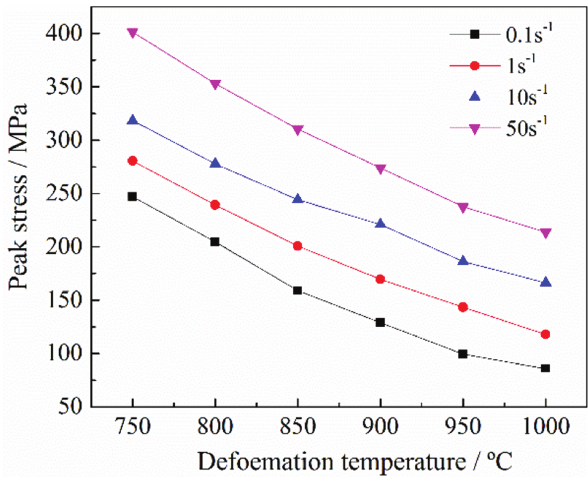
Figure 3: Peak stress in the isothermal compression of 49MnVS3 non-quenched and tempered steel at different deformation